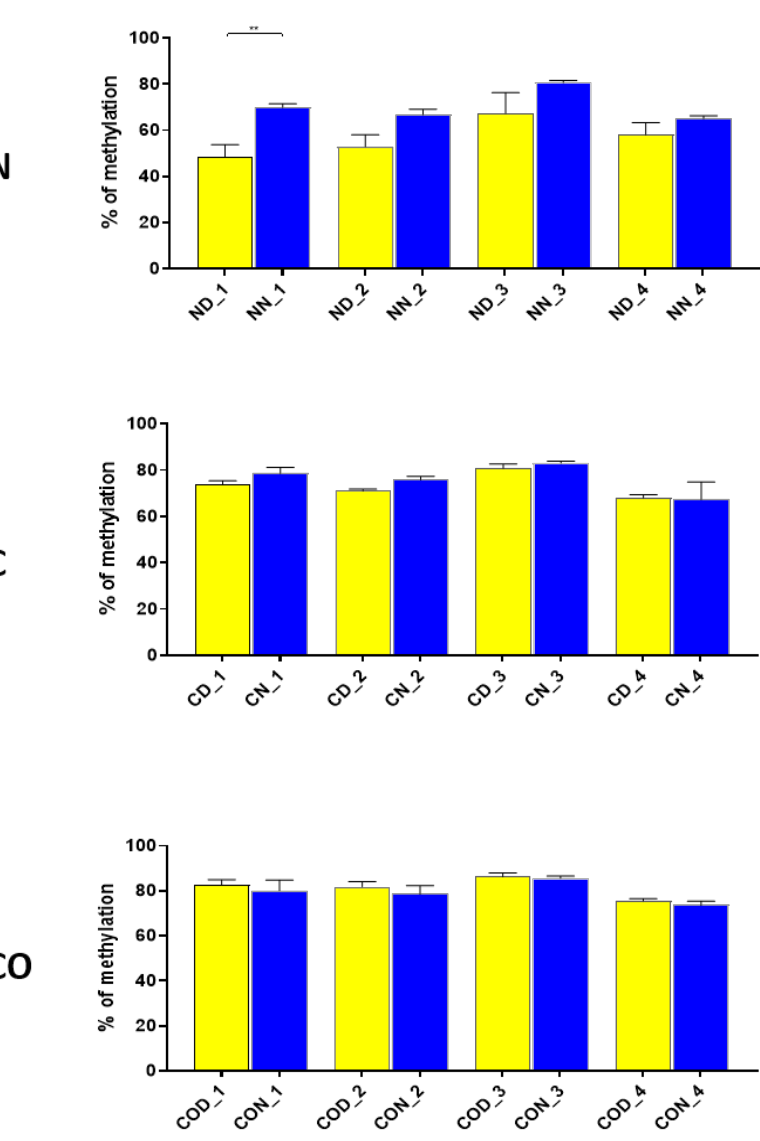
Figure 4. The difference between day (yellow bar) and night (blue bar) methylation levels in the hypothalamus in the normal (N), control (C) and CO-treated groups. The −2000—−2054 bp region methylation level was high at 60–80% and varied significantly between day and night only in the normal group in position 1 of CpG. The bars are represented as mean ± SEM. The asterisks indicate significant differences: **— p < 0.01. At the top of the figure is the examined sequence: original ( top ) and bisulfite converted with highlighted methylation position ( bottom ).